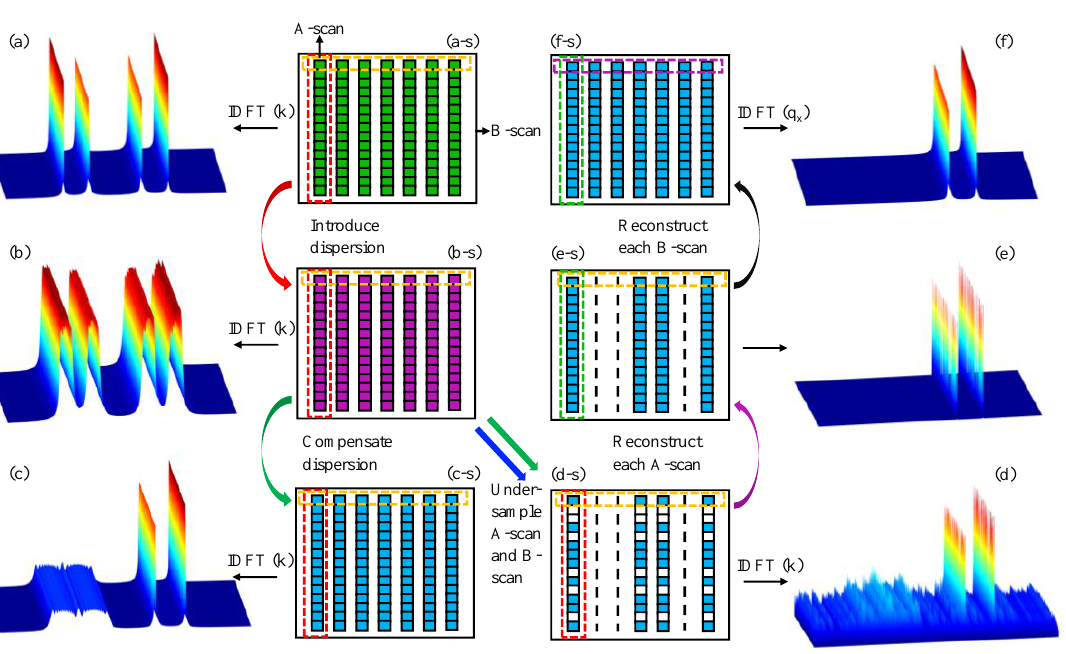
Figure 1. Schematic demonstration of the reconstruction strategy. ( a )–( f ) the patterns of the spectral data matrixes; ( a-s )–( f-s ) the simulation results of two mirror surfaces.